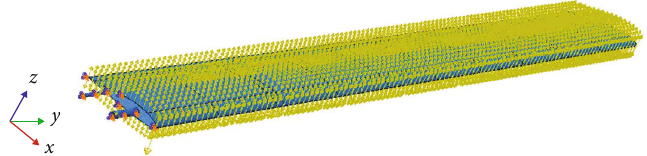
Figure 17: Finite element model of